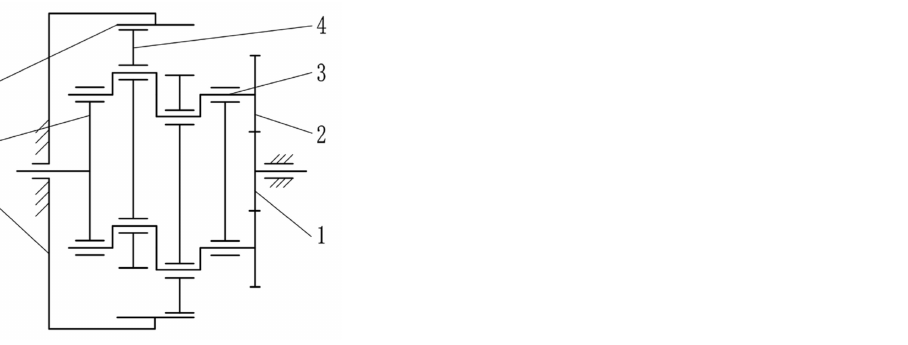
Figure 1. RV 110E gear train transmission diagram: 1—solar wheel; 2—planetary gear; 3—crank shaft; 4—cycloid wheel; 5—pinwheel; 6—planetary rack; 7—pin tooth